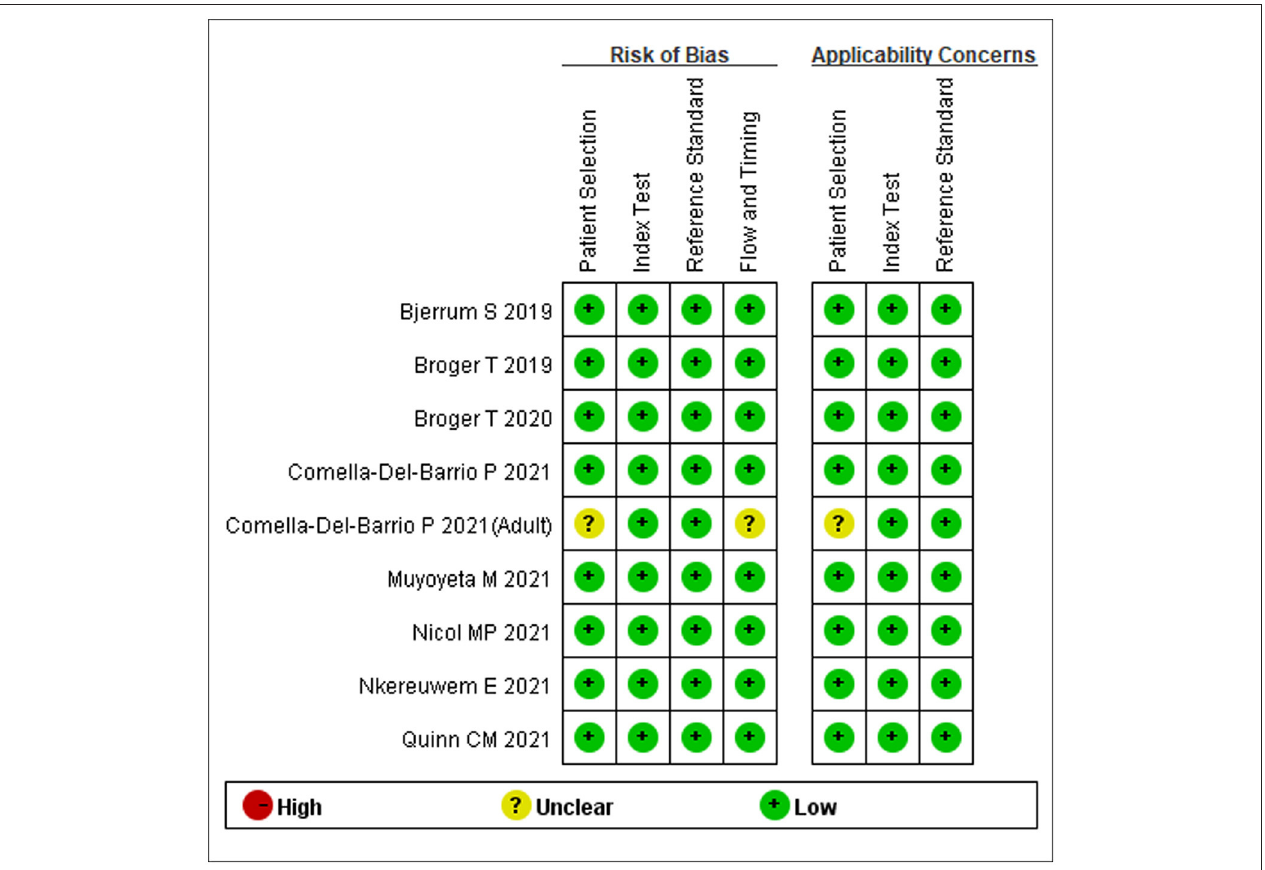
FIGURE 2 | Summary of quality assessment of included studies by the QUADAS-2